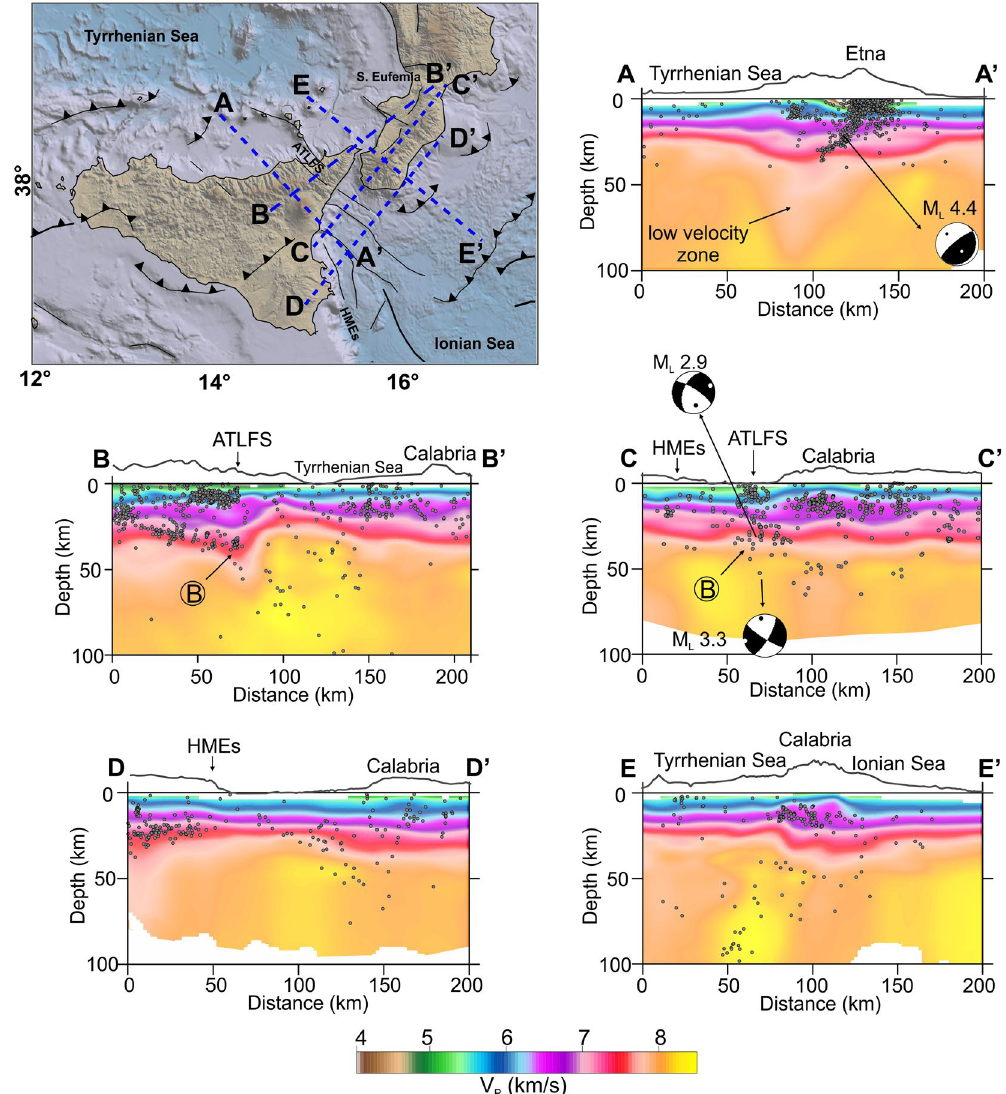
Figure 4. Vertical sections through the V P model, in km/s. Relocated earthquakes, within ± 5 km from the cross-section lines, are plotted as grey dots. Focal solutions are by refs 20,30 . Topographic profiles at the top of the sections are only indicative of the geographic location. Circled letters indicate features described in the text. The traces of the sections (AA’, BB’, … ) are reported in the sketch map. Topography is from ref. 46 . The figure was obtained using the software Surfer (version 10.7.972; http://www.goldensoftware.com/products/surfer) and QGIS (version 10.2.1; http://qgis.org). The plot was edited using Corel Draw Graphics Suite (version X5; http://